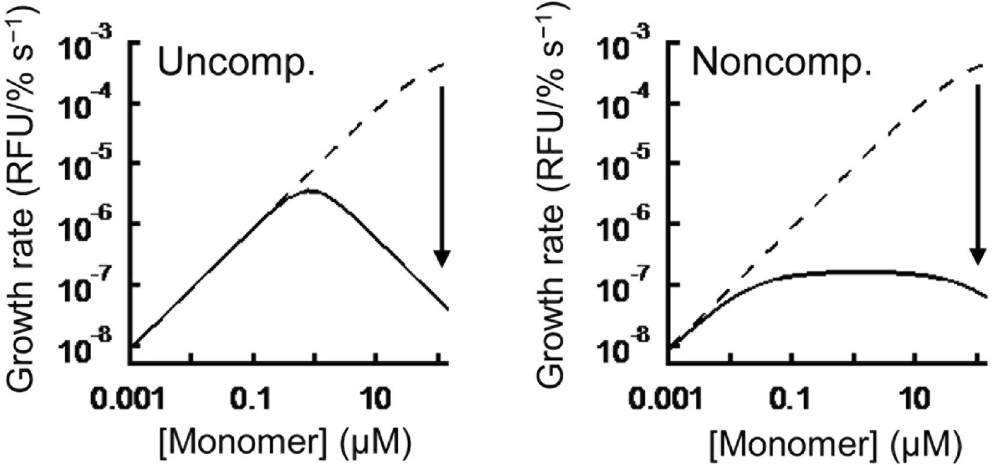
Figure 6. Native-state inhibition under a physiologically relevant condition. Predicted growth rate at 0 M GuHCl as a function of the monomer concentration (uncompetitive [left panel] and noncompetitive inhibition models [right panel]). The solid and dotted lines are the growth rates in the presence or absence of native-state inhibition,